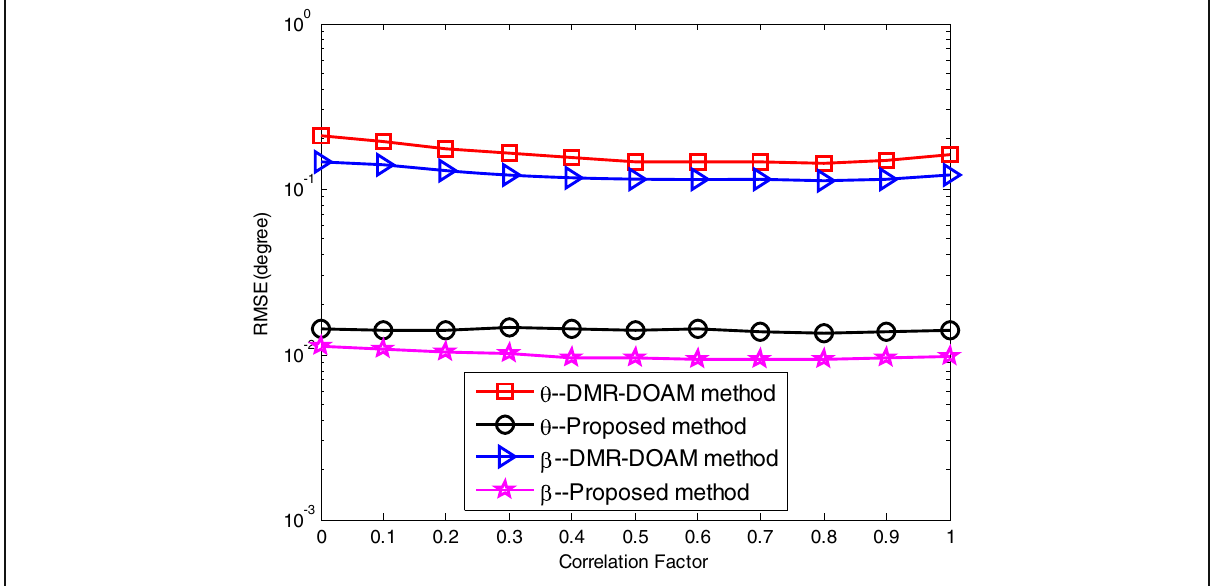
Fig. 6 The RMSE of the DOA estimates versus correlation